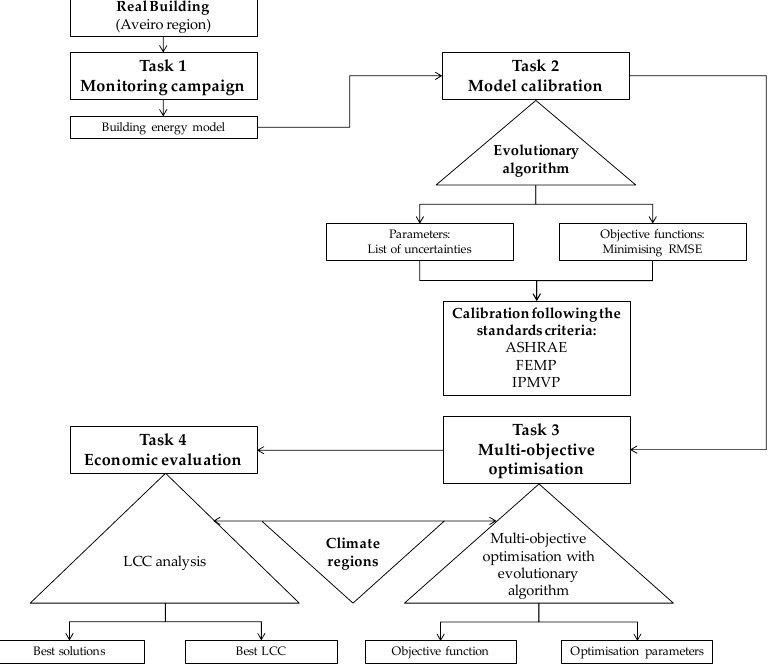
Figure 2. Methodology: Monitoring, model calibration, multi-objective optimisation and life cycle cost (LCC)